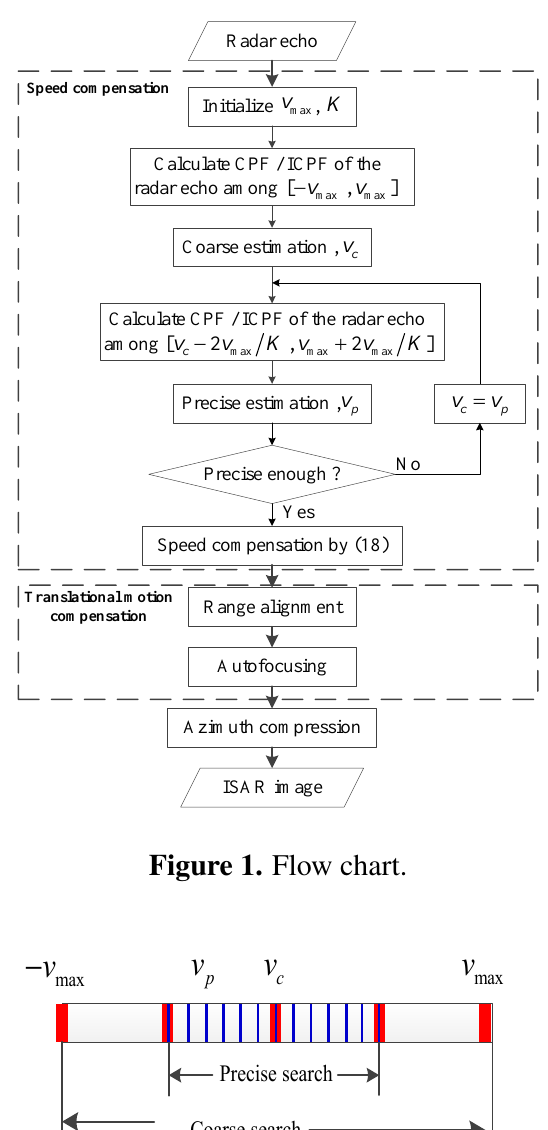
Figure 2. Illustration of the process of